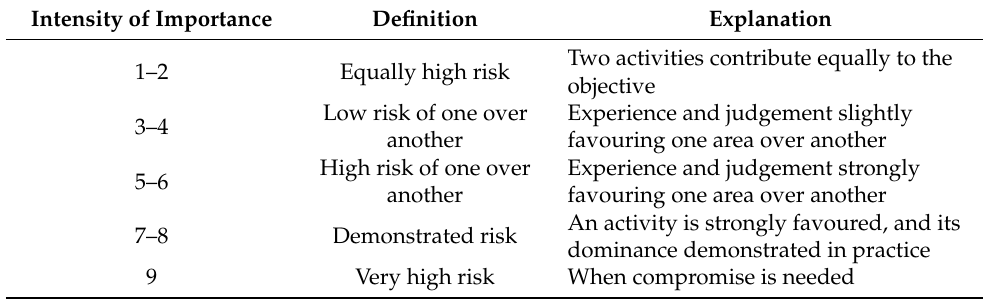
Table 1. The 9-point